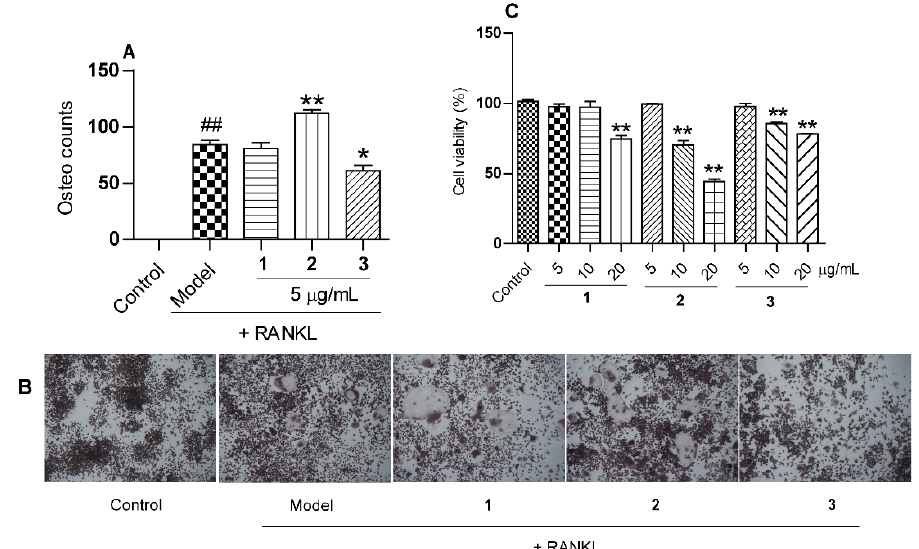
Figure 7. Effects of compounds 1–3 on RANKL-induced osteoclast formation; ( A ) osteoclast counts after compounds’ addition ( ## p < 0.01 versus control; * p < 0.05, ** p < 0.01 versus model); ( B ) repre- sentative TRAP staining images after compounds’ intervention; ( C ) dell viability of the compounds with various concentrations (5, 10, or 20 μ g/mL) on macrophages RAW 264.7 (** p < 0.01 versus con- trol). RANKL, receptor activator for NF- κ B ligand; TRAP, tartrate-resistant acid phosphatase; Osteo, osteoclast.